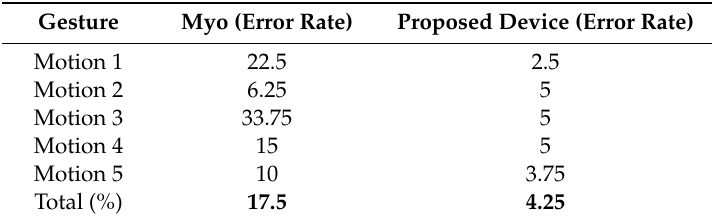
Table 2. Results of comparison tests between the proposed device and myo.